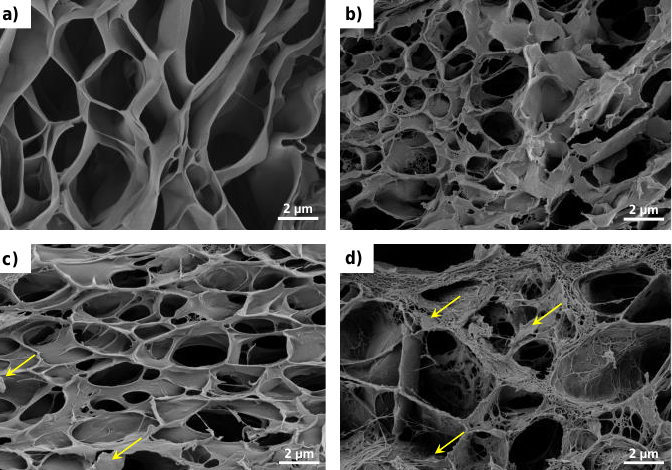
Figure 3. High-resolution FESEM cross-section pictures of the hydrogels: ( a ) c-PVA, ( b ) c-PHBV/PVA, ( c ) c-PHBV/PVA 0.2% G, and ( d ) c-PHBV/PVA 0.8% G. Cross-sections were obtained after cryogenic cut with liquid nitrogen. Magnification: 7 kX.